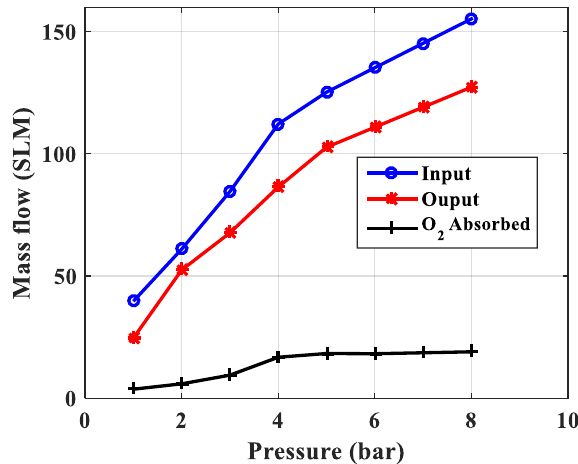
Figure 16. The amount of adsorbed material depends on the adsorption pressure.